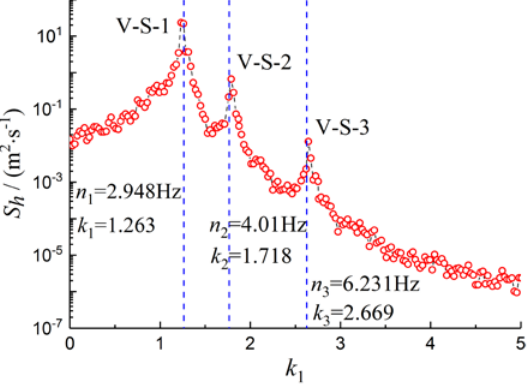
Figure 18. Buffeting response measured in taut strip model test.